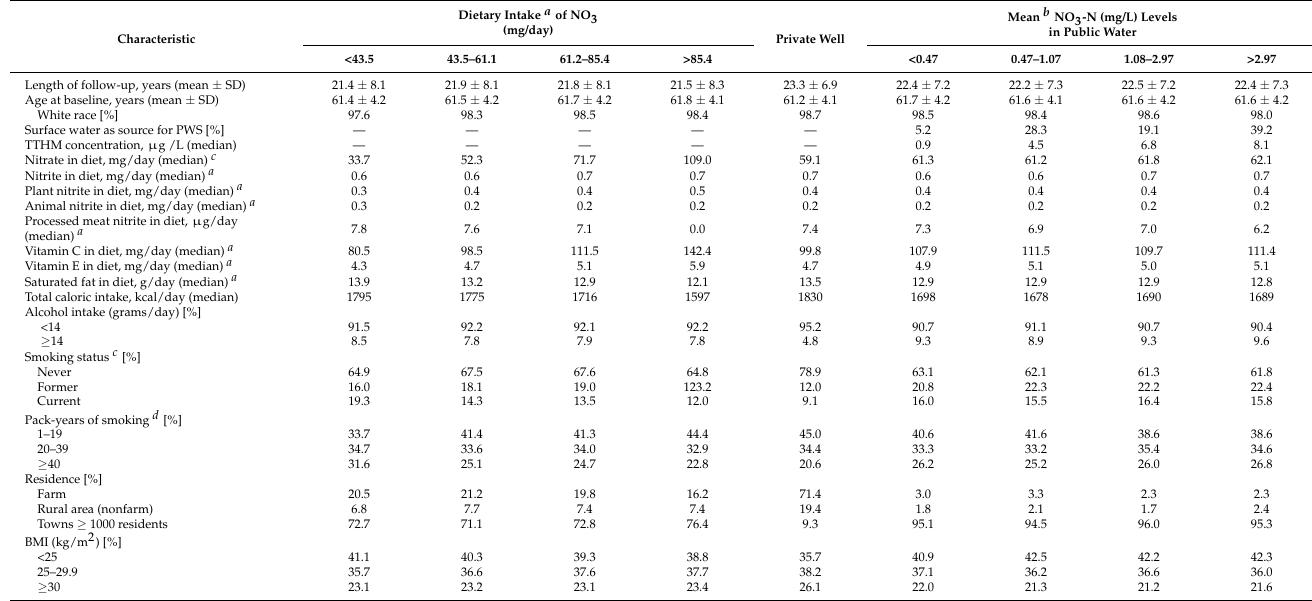
Table 1. Characteristics of Iowa Women’s Health Study participants in the dietary cohort (N = 33,964) and drinking water cohort (N = 20,507). The drinking water cohort included IWHS participants with >10 years at their drinking water source, by private well use (N = 4930), and nitrate-nitrogen (NO 3 -N) levels in public water (N = 15,577).